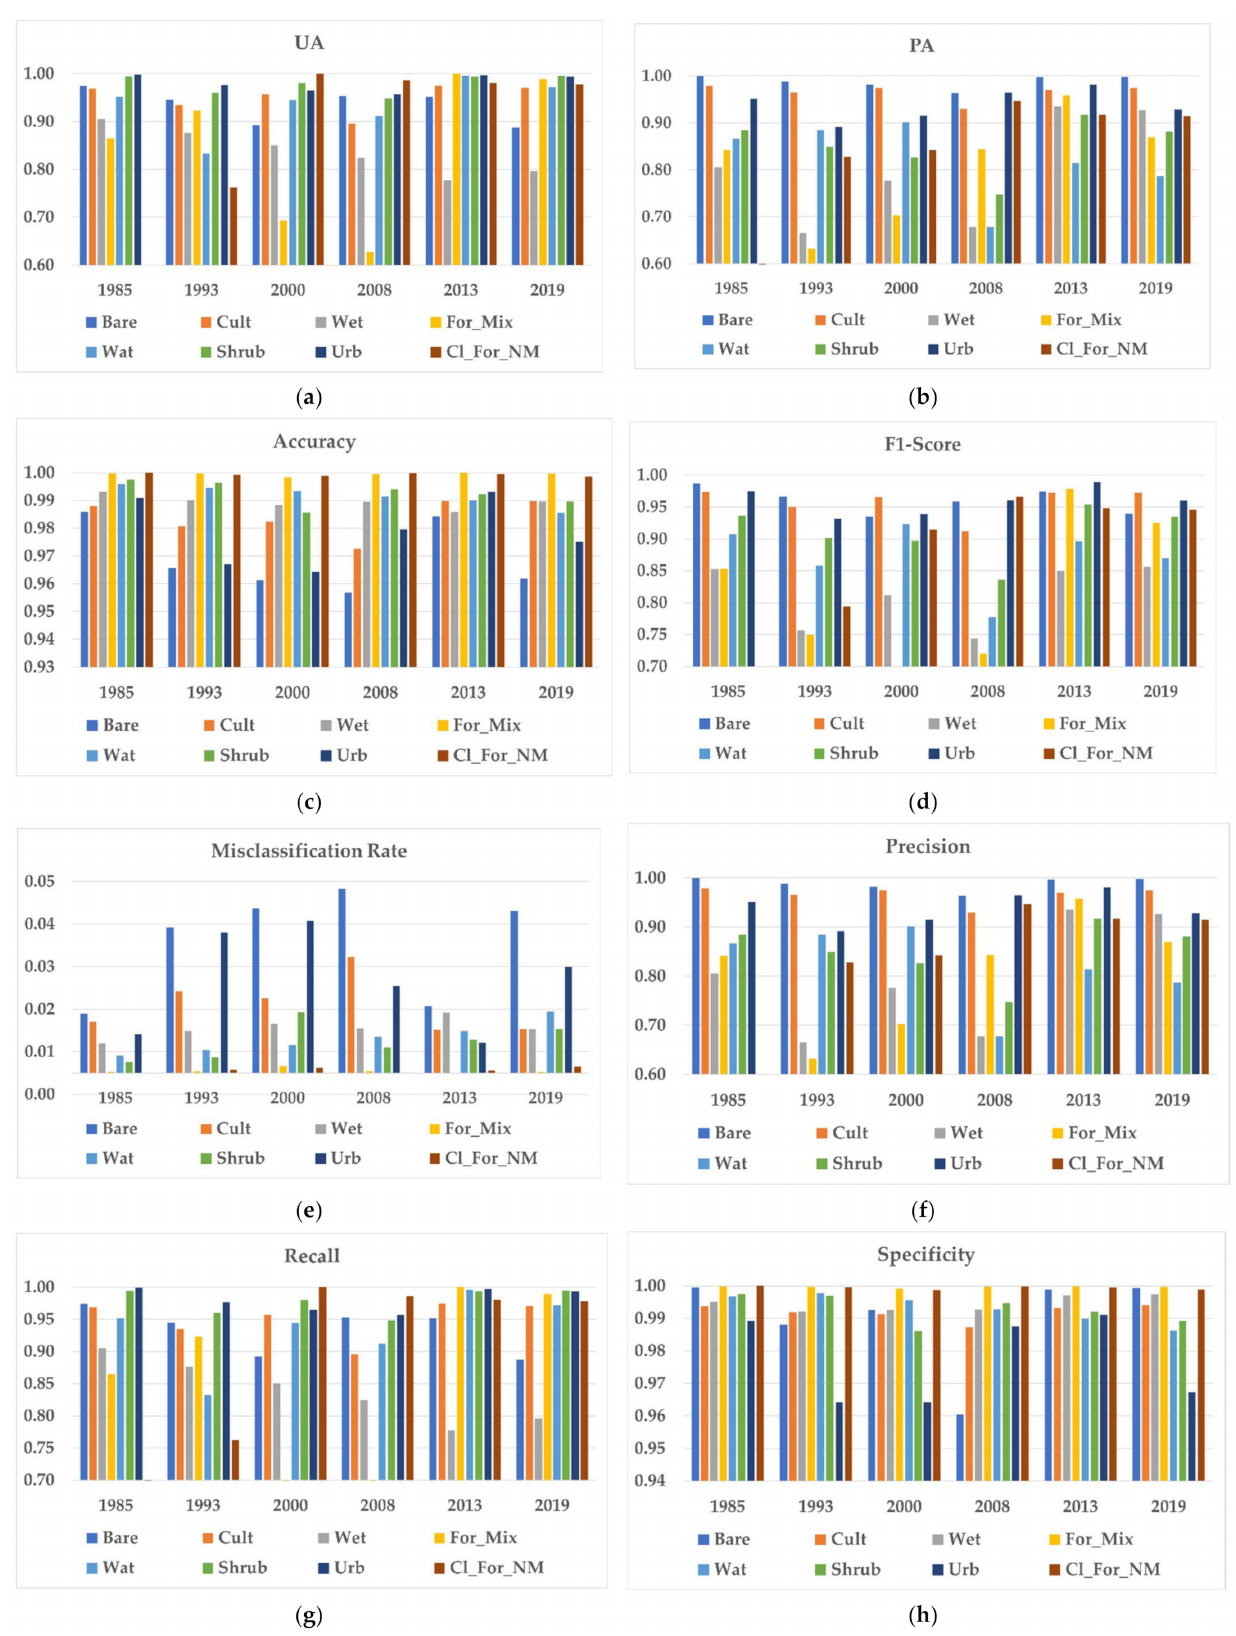
Figure 7. Estimated error matrix of sample counts with ( a ) user’s accuracy; ( b ) producer’s accuracy; ( c ) accuracy; ( d ) F1-score; ( e ) misclassification rate; ( f ) precision; ( g ) recall; ( h )